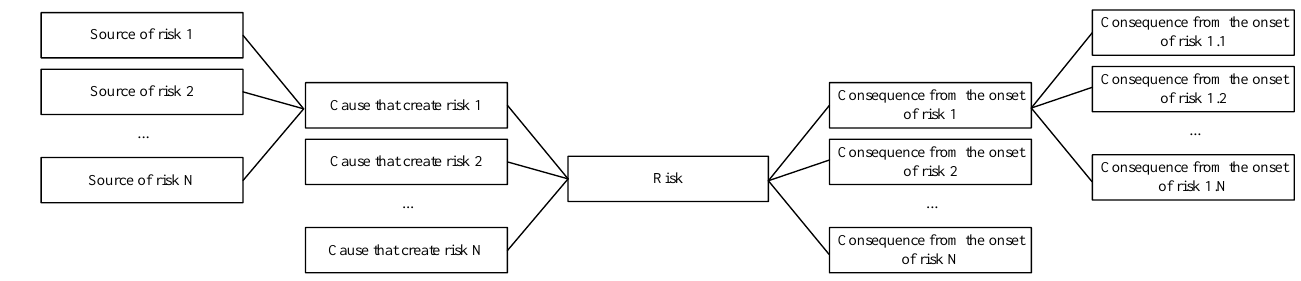
Figure 1. Risk structure—risk, causes that create risk, sources of risk and consequences from the onset of risk.